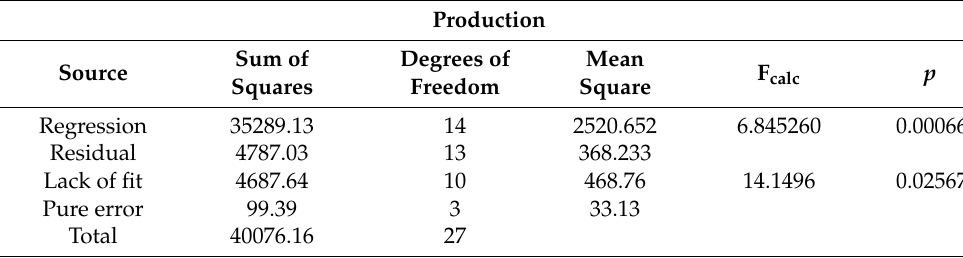
Table 6. Analysis of variance of second-order polynomial